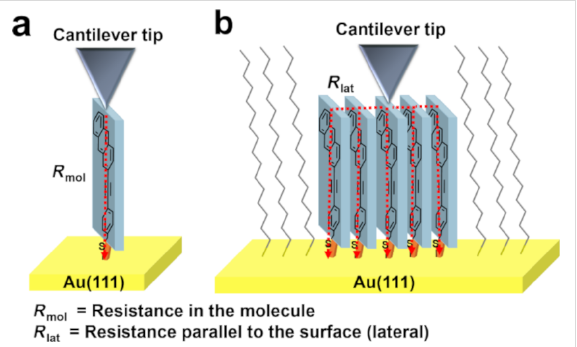
Figure 3: a) Simple model of resistance within a single thiol molecule on the gold(111) surface. b) Model of charge transfer within a continu- ous SAM. The number of parallel resistors depends on the island size. The PAT is shown schematically in blue with the S anchor group on a gold surface, while the respective resistances are shown laterally and within the